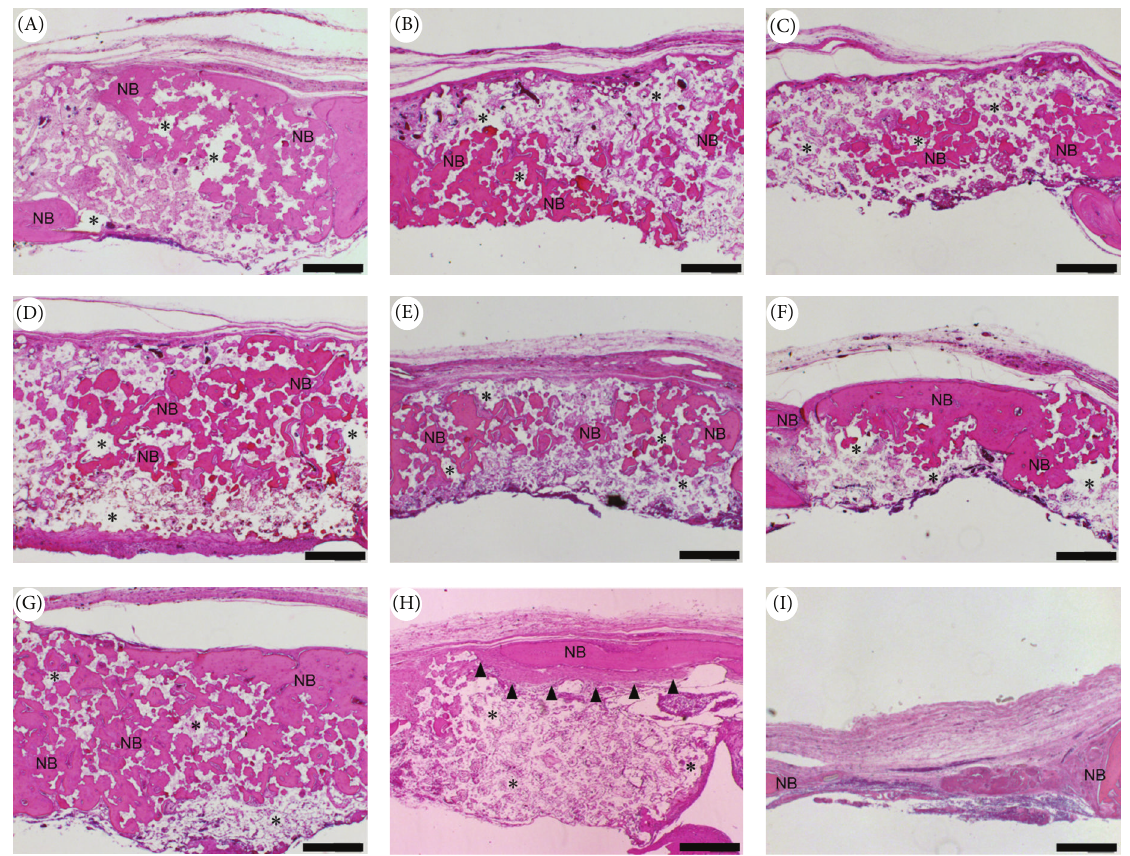
Figure 2: Low magnification images of hematoxylin and eosin (HE) staining. (a) 𝛽 -TCP alone; (b) 1 𝜇 g G-CSF in solution form; (c) 5 𝜇 g G-CSF in solution form; (d) 20 𝜇 g G-CSF in solution form; (e) free gelatin hydrogel; (f) 1 𝜇 g G-CSF with gelatin hydrogel; (g) 5 𝜇 g G-CSF with gelatin hydrogel; (h) 20 𝜇 g G-CSF with gelatin hydrogel; and (i) untreated defect. Note the dense fibrous tissue surrounding focal bone formation in group H (arrow heads). Original magnification 40x; scale bar = 500 𝜇 m. NB: newly formed bone; ∗ remaining 𝛽 -TCP.